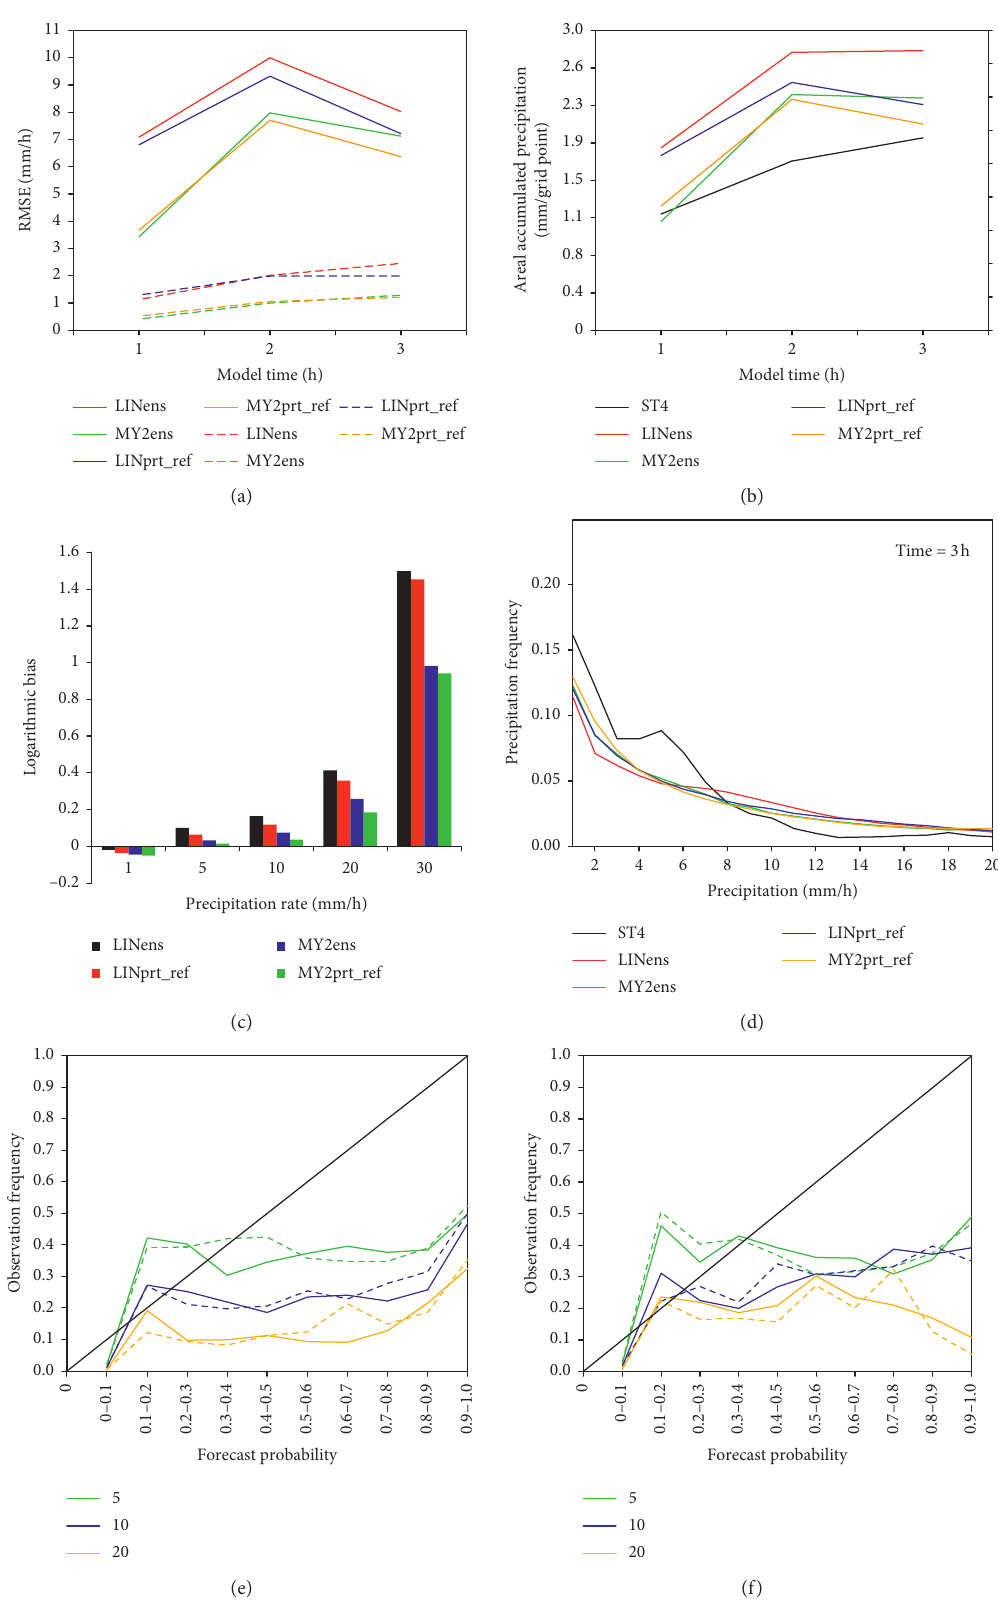
Figure 6: (a) RMSEs of the ensemble mean (solid) and ensemble spread (dashed) of hourly precipitation in the Alabama case, (b) averaged areal accumulated precipitation of ensemble members and observations, (c) the logarithmic bias of hourly precipitation averaged over all ensemble members and times, (d) the observed precipitation frequency (black) and the corresponding ensemble frequencies at 03 UTC, the reliability diagrams for (e) LINens (solid) and LINprt_ref (dashed) and (f) MY2ens (solid) and MY2prt_ref